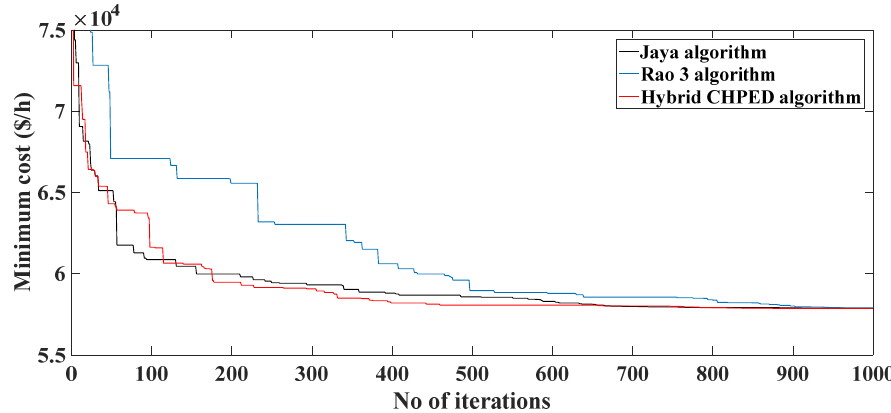
Figure 4. Minimum price convergence curve for case 1 of test system 2.